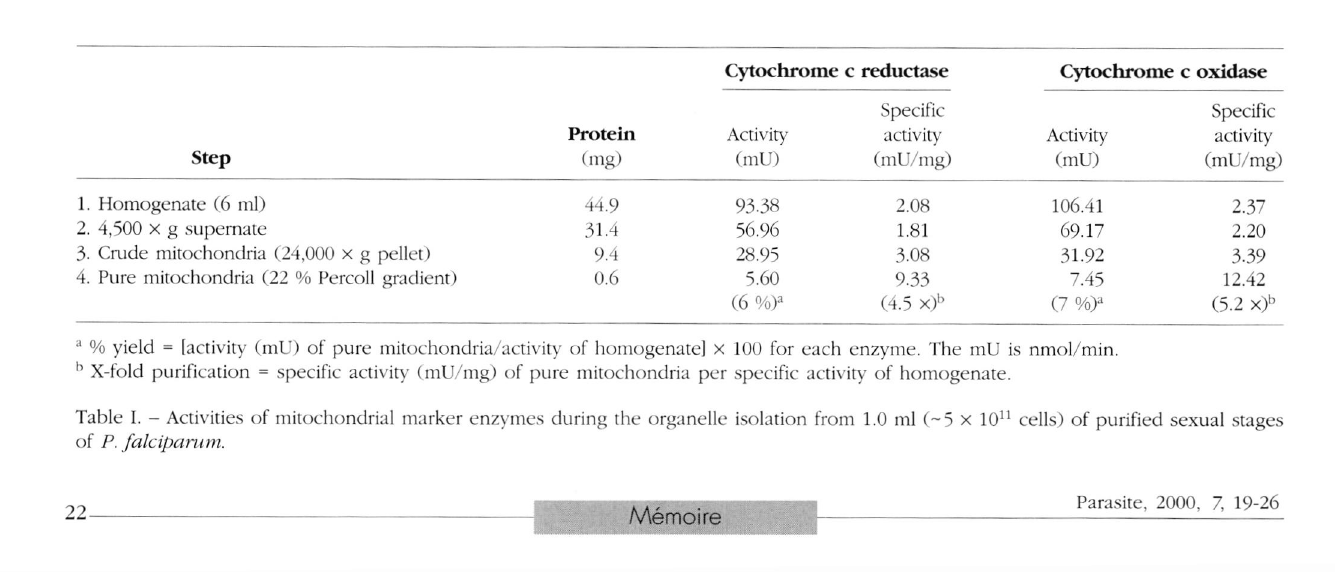
Fig. 3- - Transmission electron micrograph of the sexual blood stage of P. falciparum (gametocyte stage IV). Many mitochondria are observed in the single parasite (A). A higher magnification of two organelles containing numerous cristae structure (arrowhead) is shown (B). The bar represents 1 µm. M, mitochondria; P. crystal line pigment.